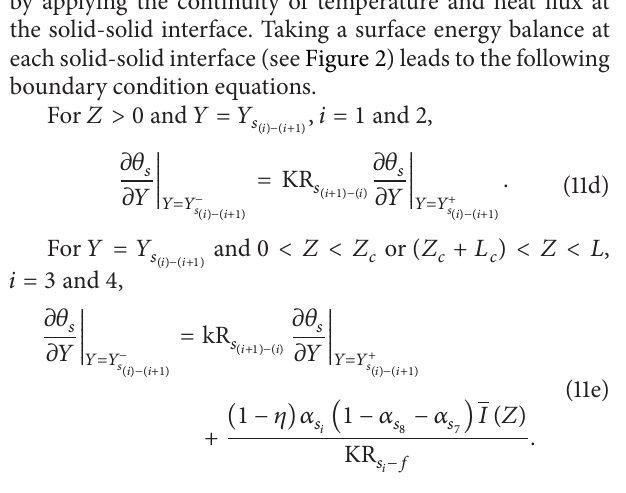
Figure 4: Variations in solar cell temperature obtained using different values of SD, when 𝑧 0 = 0.5 , Re = 500 , 𝜀 = 0.95 , and 𝐶 = 100 .